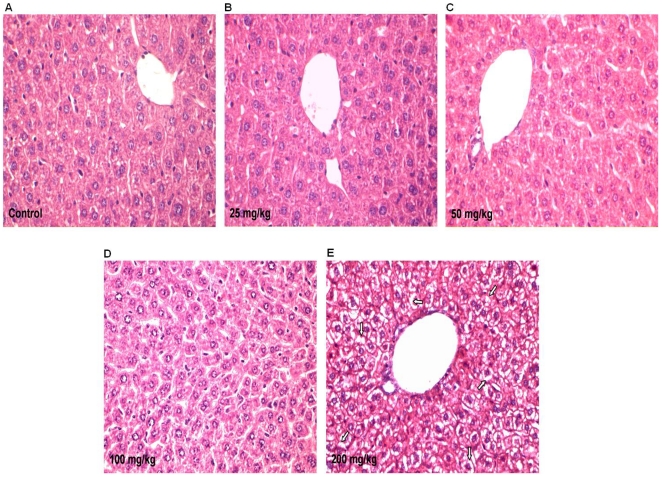
Histological examination of liver sections.Photomicrographs of transverse section of mice liver (A) Control, (B) 25 mg/kg, (C) 50 mg/kg Apigenin treated groups. Slight hydropic changes and degeneration of cytoplasm within hepatocytes were observed in (D) 100 mg/kg, and (E) 200 mg/kg Apigenin treated groups respectively. Arrows indicated the degenerated hepatocytes in 200 mg/kg Apigenin treated group.